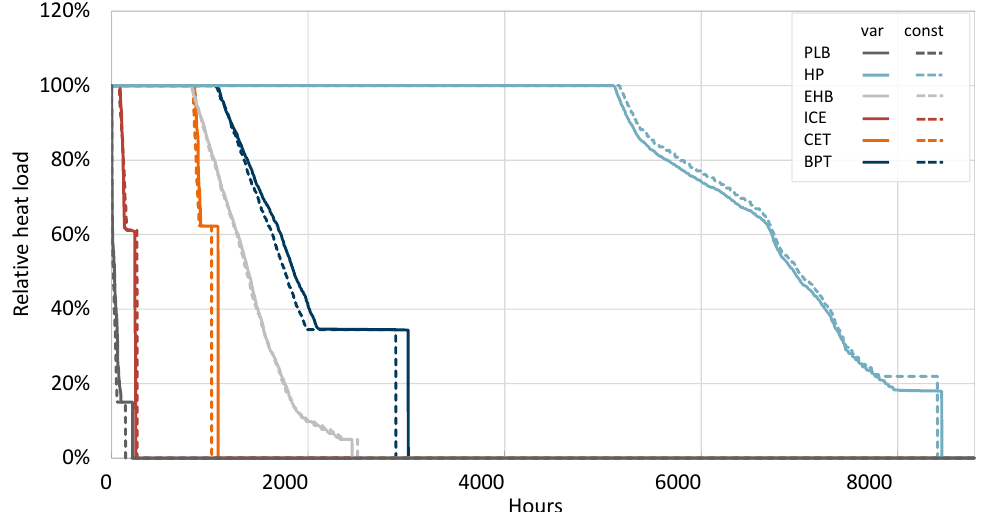
Figure 5. Load duration curves for variable (solid) and constant (dashed) medium supply temperature setups in the PTH (power to heat)